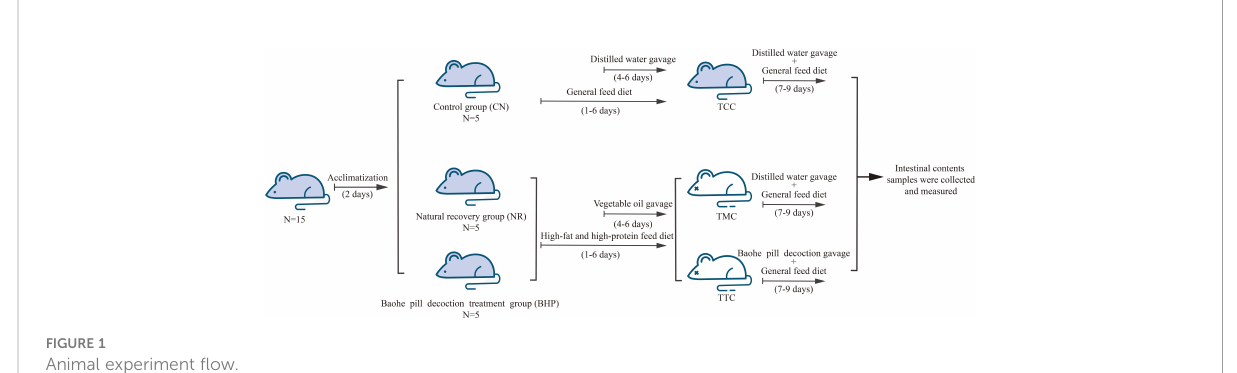
FIGURE 1 Animal experiment fl